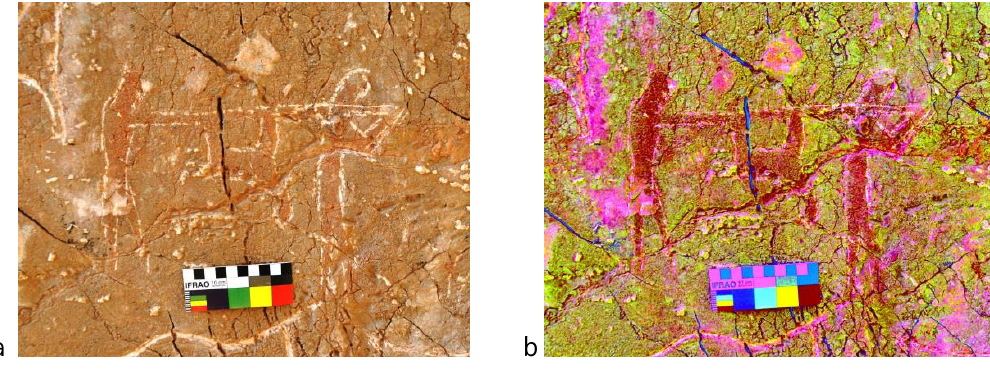
Figure 14. Site V. ( a ) Two individuals carrying a quadruped. ( b ) Same photo enhanced using